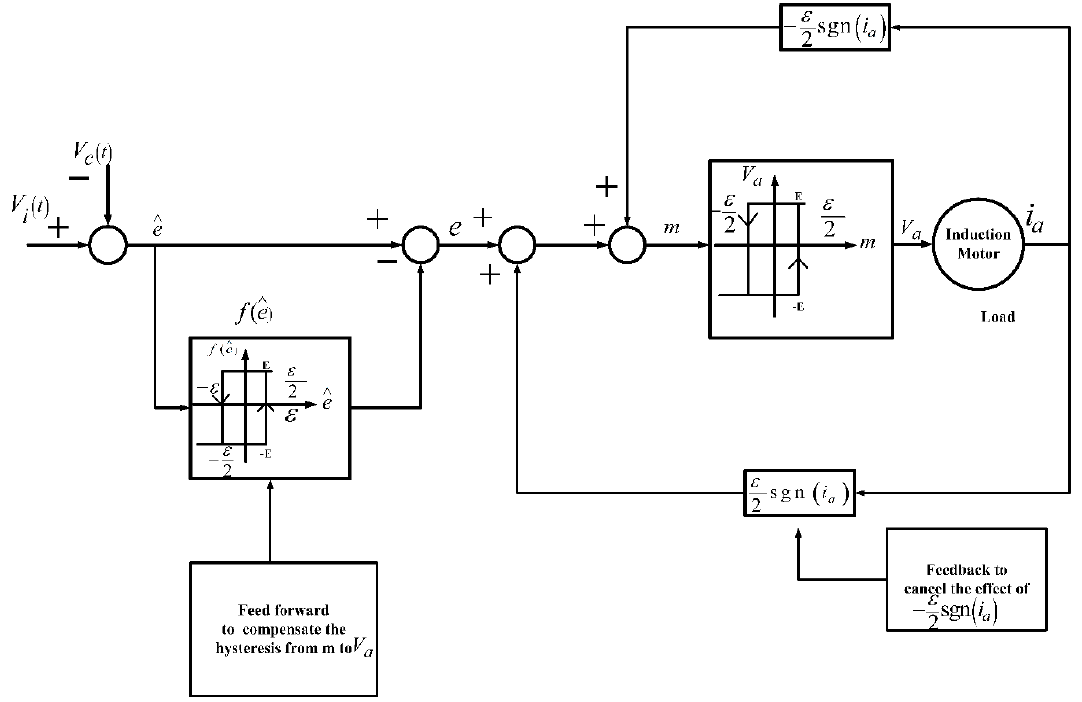
Figure 7. Proposed model for the (DTC) method.